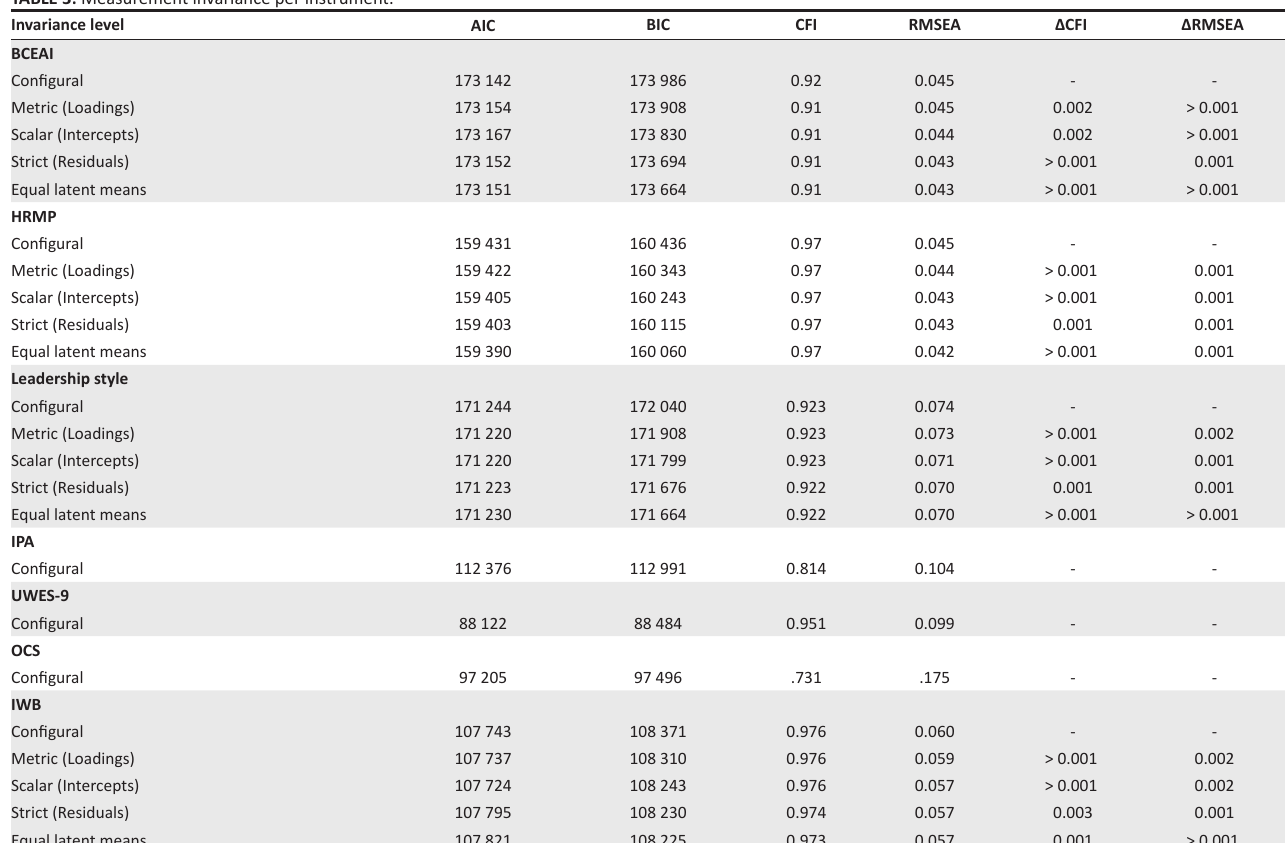
TABLE 3: Measurement invariance per instrument.